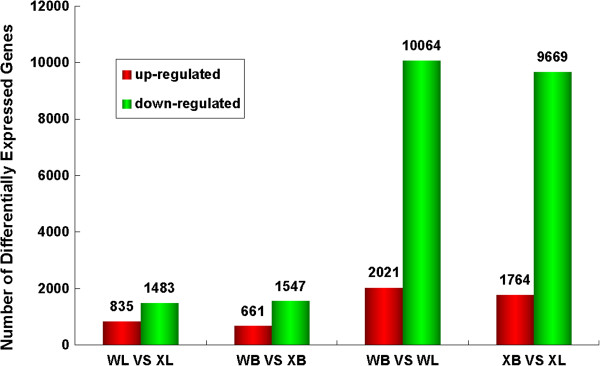
Differential expression analysis of unigenes by DGE. WL and WB indicate liver and brain in nonfeeders, respectively, while XL and XB indicate liver and brain in feeders. The superscripts of each column represent the number of differentially expressed genes between groups.